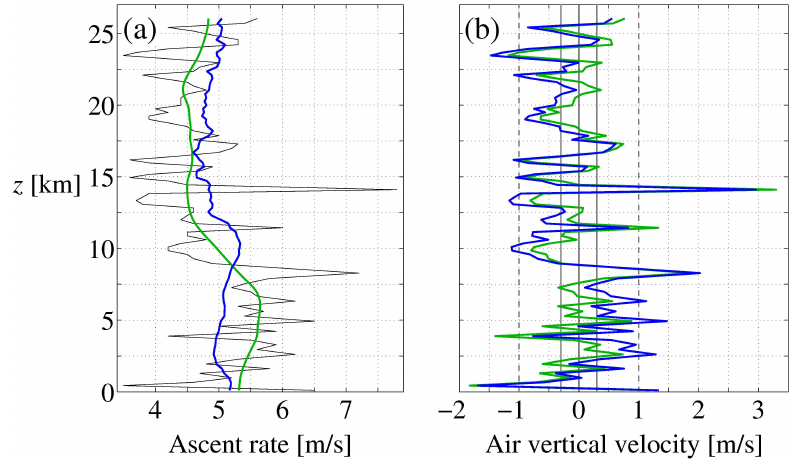
Fig. 9. Comparison of the model with the method based on the smoothing of the measured balloon ascent rate in the case of LUAMI flight L025 launched on 19 November 2008 at 22:45UTC. (a) Vertical profile of the balloon ascent rate in still air derived from the model (—); smoothed profile of the balloon ascent rate measured during the actual flight (—) (for a description of the smoothing technique, see Sect. 2.3). The actual ascent rate derived from the GPS data is indicated as a thin black line for comparison. (b) Corresponding profiles of the air vertical velocity estimated from the model (—) and from the smoothed profile of the measured balloon ascent rate (—). The vertical velocities derived by Hoyle et al. (2005) from aircraft measurements are indicated here as thin gray lines for comparison: typical gravity-wave fluctuations, ± 0 . 3ms − 1 (—); strong fluctuations representing less than ∼ 2% of all wave occurrences, ± 1ms − 1